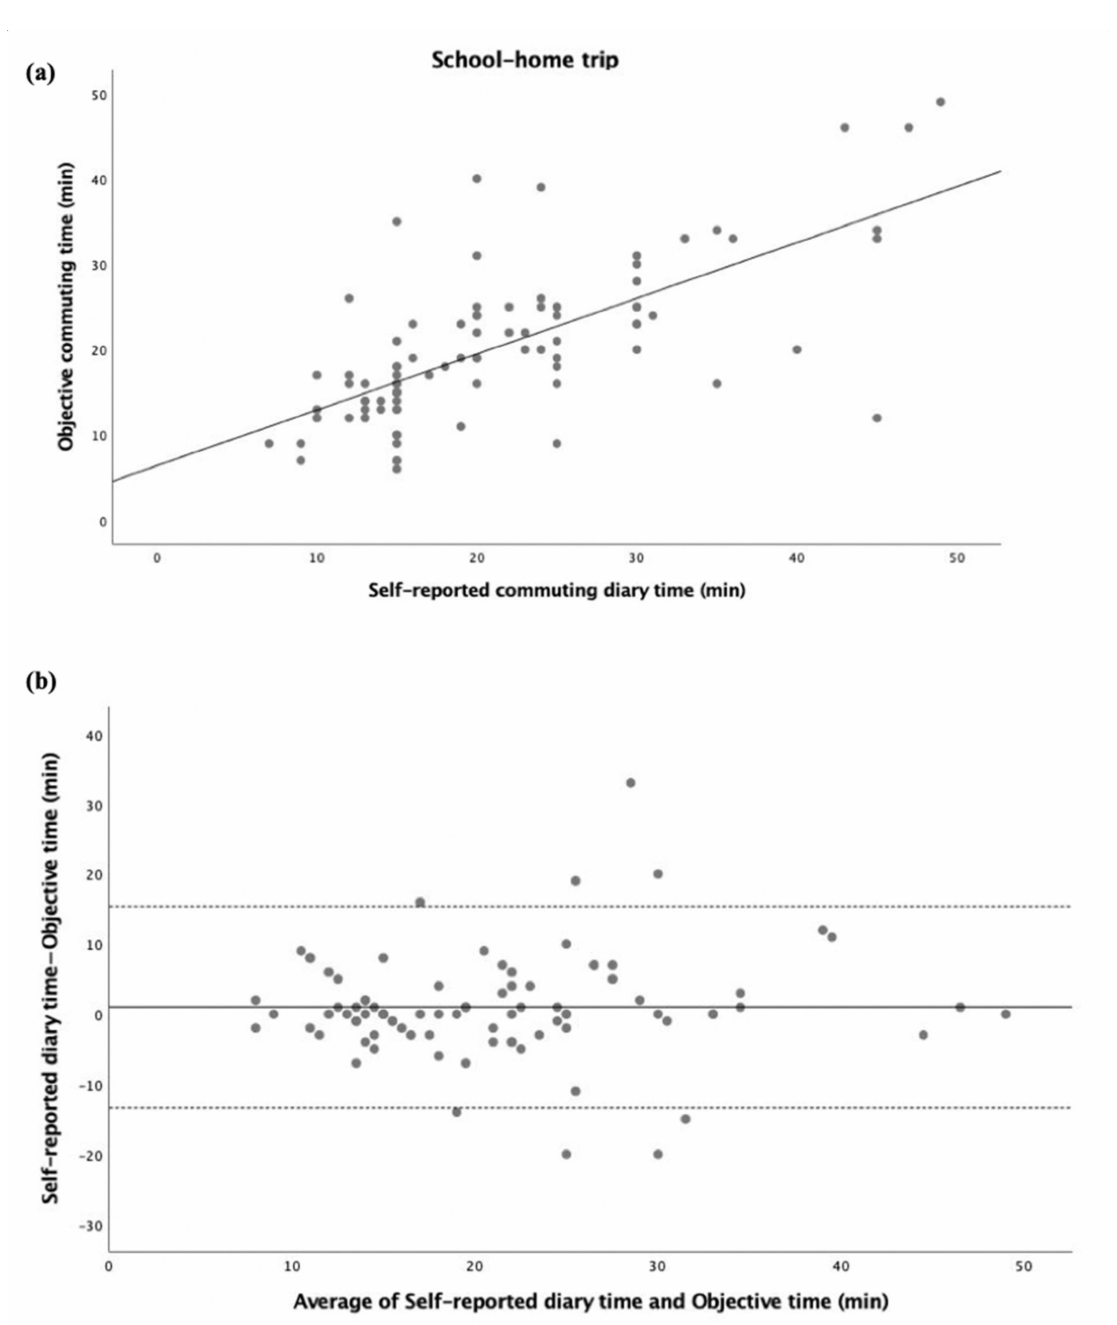
Figure 5. Commuting time expressed as minutes (school–home trip). ( a ) Regression of the objective commuting time (y) vs. (x) the self-reported commuting diary time. The regression equation is y = 6.42 + 0.65x. ( b ) Bland–Altman plot of the commuting time of the school–home trip between self- reported diary time and objective time (y) vs. average of self-reported diary time and objective time (x). The central dotted line represents the mean of differences between the objective time measure and the self-reported time measure; the upper and lower dotted lines represent the upper and lower 95% limits of agreement (mean differences + 1.96 standard deviations of the differences),